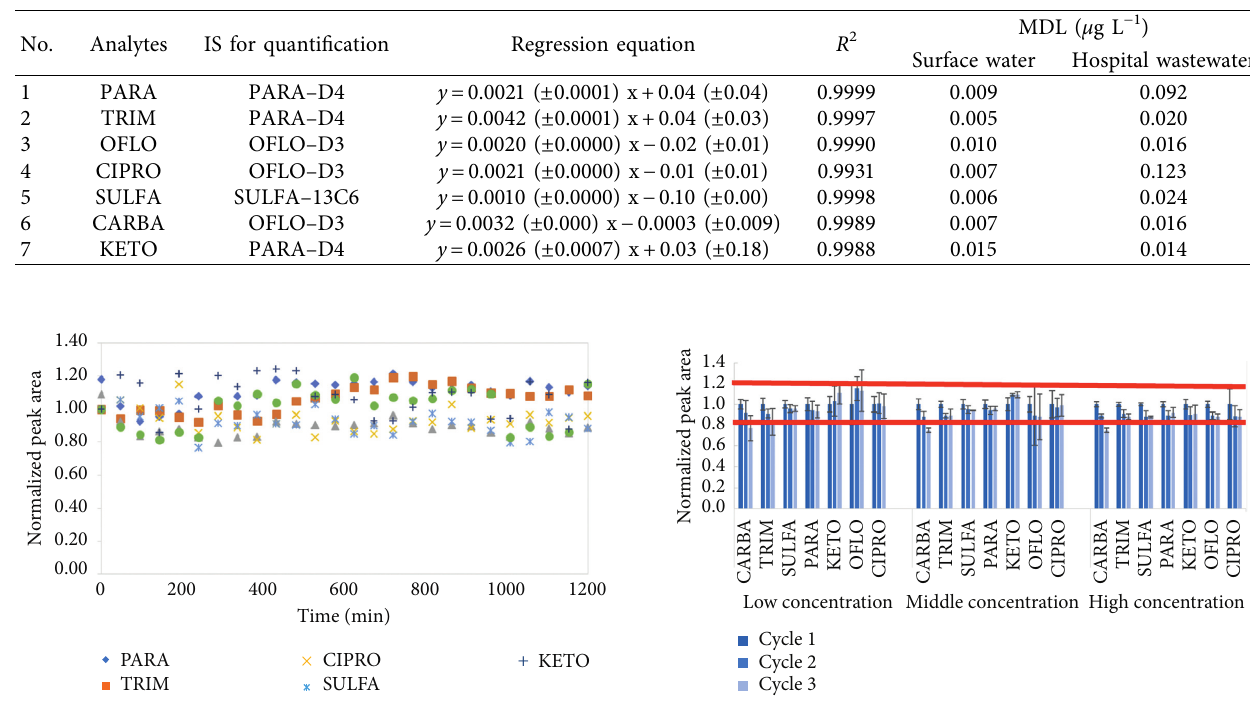
Table 2: Analytical figure of merits of seven major pharmaceutical residues by UPLC-MS/MS.